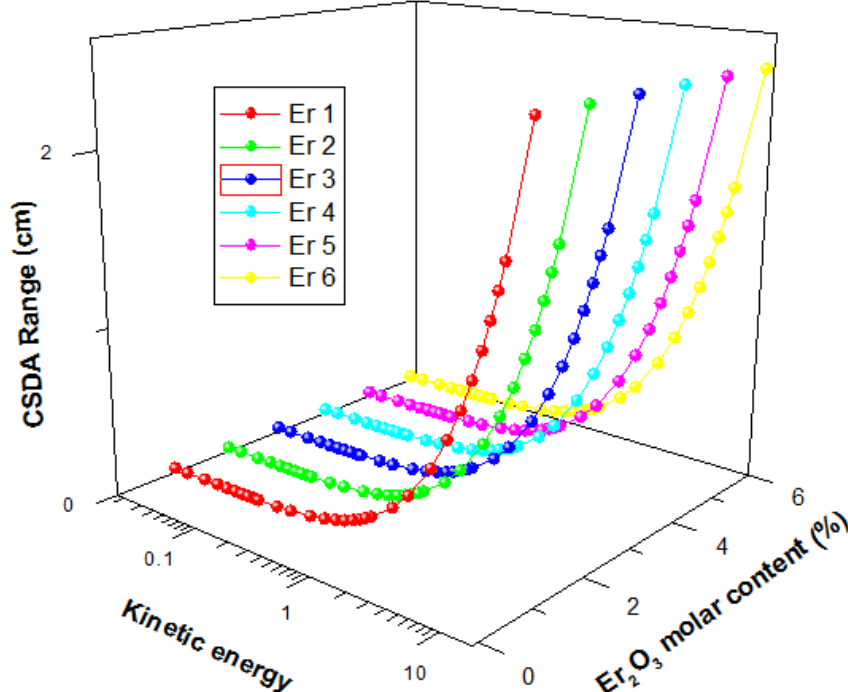
Figure 13. CSDA range of electrons in the glasses as a function of kinetic energy.